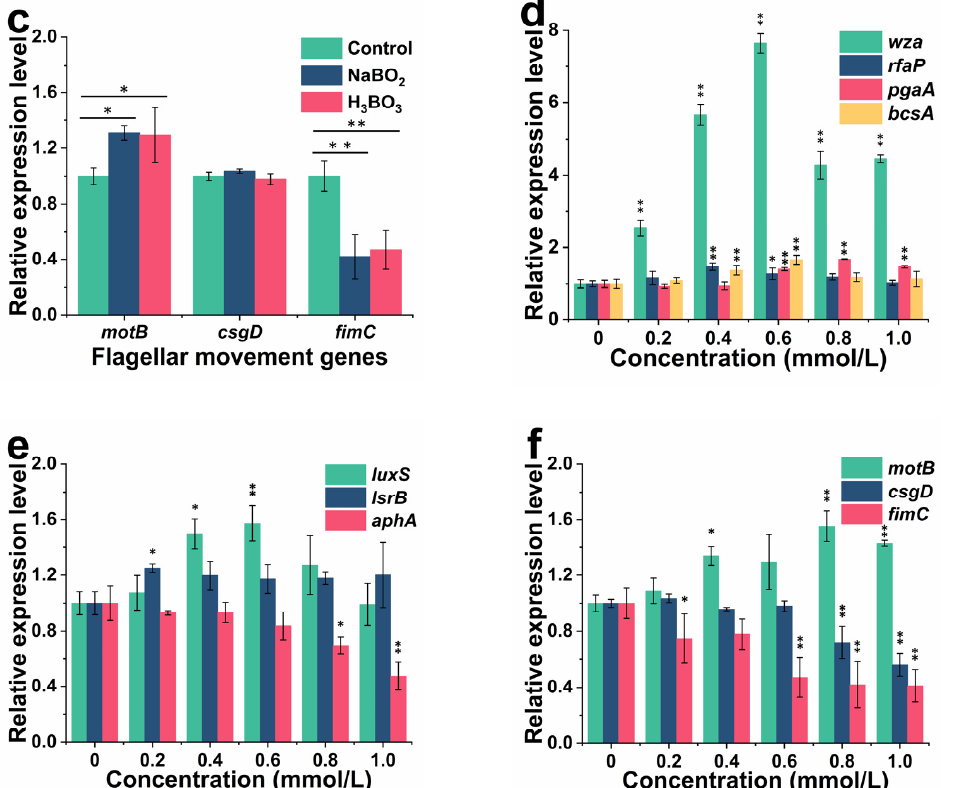
Figure 7. Effects of boron derivatives types on biofilm formation genes ( a ), quorum sensing genes ( b ), flagellar movement genes ( c ) expression levels, and effects of H 3 BO 3 concentrations on biofilm formation genes ( d ), quorum sensing genes ( e ), and flagellar movement genes ( f ) expression levels. The expression of genes was analyzed by real-time PCR with three independent biological replicates. * p < 0.05: significant compared with the control, ** p < 0.01: highly significant compared